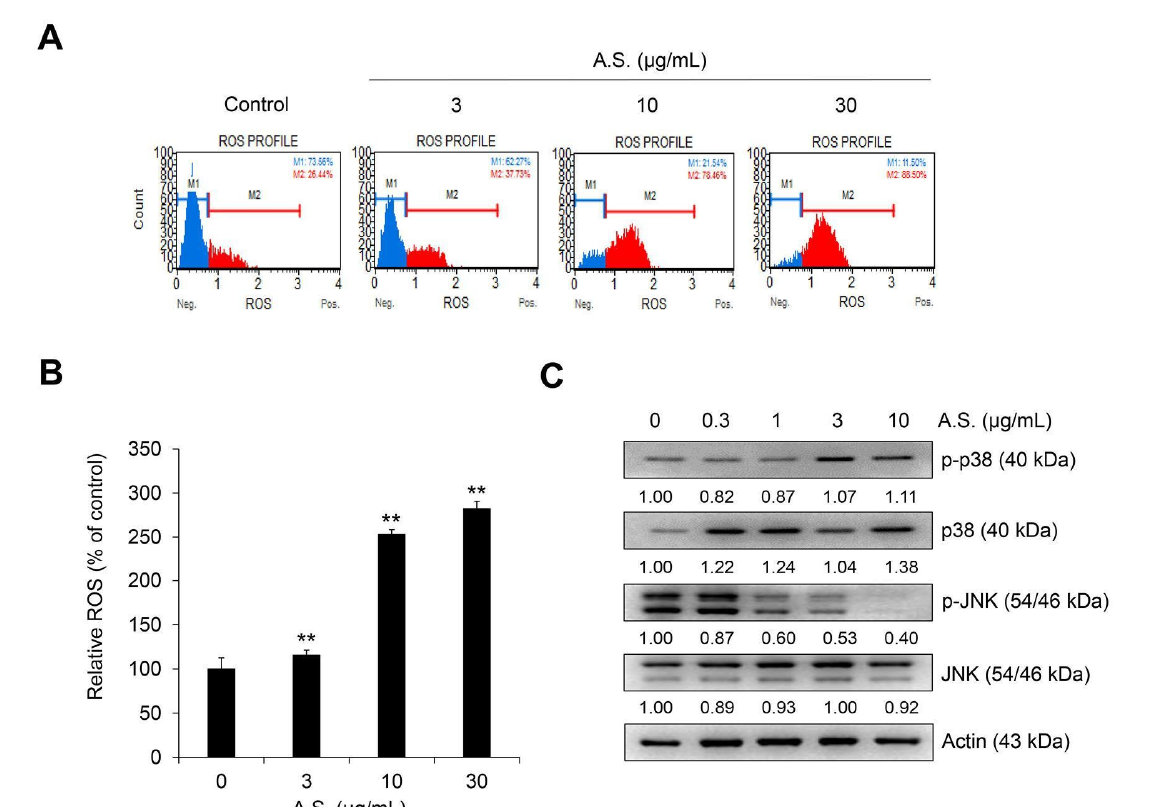
Figure 3. A.S. extract induces reactive oxygen species (ROS) production and the phosphorylation of MAPK p38. Jurkat cells were treated with A.S. extract for 24 h. ( A ) Dihydroethidium stained ROS-positive cells were analyzed using the MUSE®Cell Analyzer and ( B ) the relative percentage of ROS was measured. ** p < 0.01 (vs. control). Experiments were performed in triplicate. Data are presented as mean ± SD. Jurkat cells were treated with A.S. extract for 24 h. ( C ) Expressions of p38 and JNK and its phosphorylated forms were measured by Western blot, with actin as a loading control. The detected band intensities were quantified based on ImageJ software (NIH, USA), and the relative ratio between cytosolic proteins was normalized by actin.